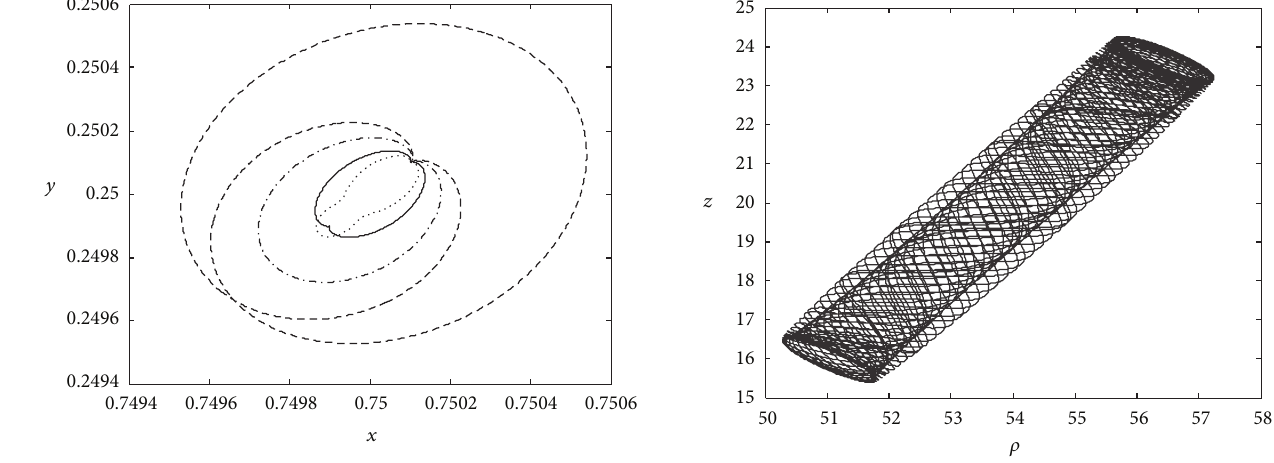
Figure 9: Quasiperiodic orbits by the controller near the degener- ated equilibrium: 𝐺 1 = 0, 𝐺 2 = 0, 𝐺 3 = 0.3, Δ = 0.0005 . the unit circle in the complex plane. Considering the relative dynamics on a 𝐽 2 -perturbed mean circular orbit, the Floquet stability of the periodic Hamiltonian system is obtained by the larger controller gain rather than the critical gain (𝐺 1 = = 𝐺, 𝐺 = Δ = 0) , as shown in Figure 𝐺 2 3